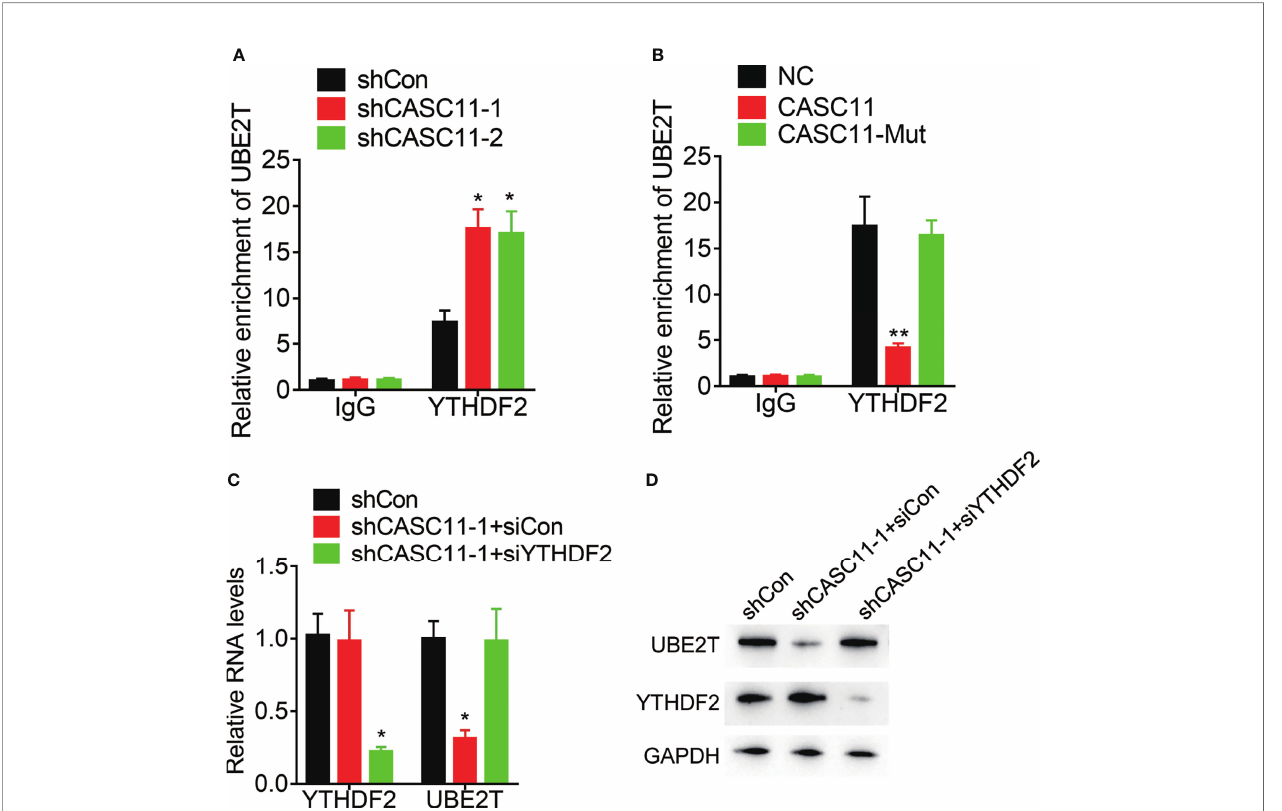
FIGURE 6 | CASC11 attenuates the association between YTHDF2 and UBE2T mRNA. (A) The interaction between YTHDF2 and UBE2T mRNA was detected in control and CASC11 knockdown Hep3B cells using RIP assay. (B) The interaction between YTHDF2 and UBE2T mRNA was detected in control and wild-type and mutant CASC11 overexpressing Huh7 cells using RIP assay. (C) The CASC11 knockdown Hep3B cells were transfected with YTHDF2 siRNA, and the mRNA level of UBE2T was detected using qRT-PCR. (D) The CASC11 knockdown Hep3B cells were transfected with YTHDF2 siRNA, and the protein level of UBE2T was detected using qRT-PCR. Data are mean ± SD. *p < 0.05, **p <